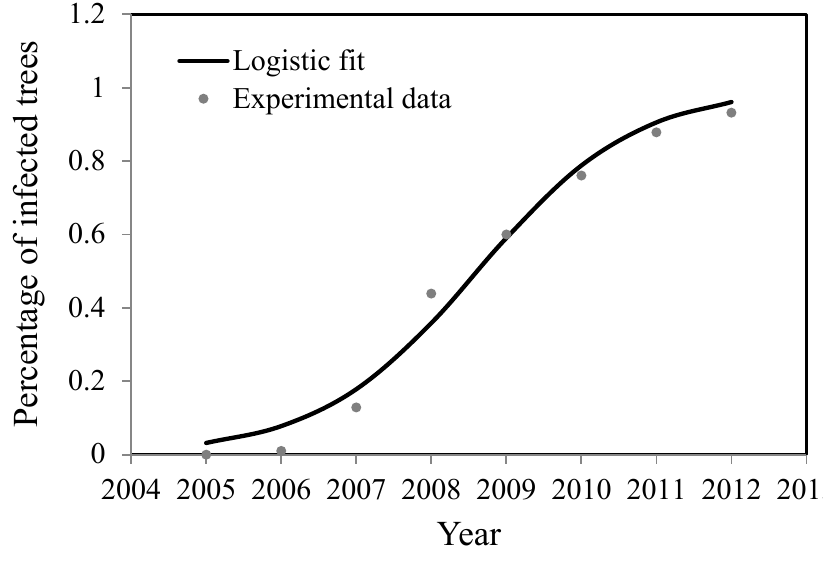
Figure 1. Ash dieback incidence is fitted to a logistic curve using least-squares method. The dots denote the experimental data recorded by Enderle et al . [21]. The solid line corresponds to the disease fitted